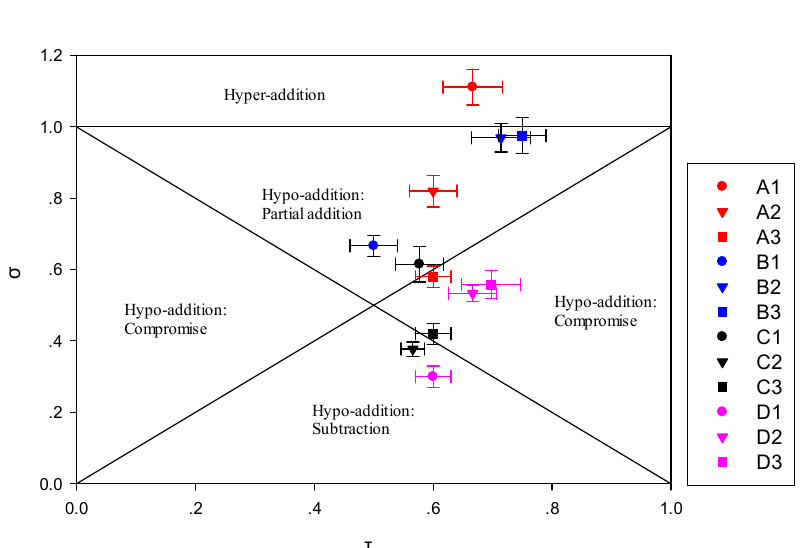
Figure 6. Individual impact of alcohols on sensory attributes of Terpenes Recombination. 1–3, at high, medium, and low level respectively. A, isoborneol; B, D -fenchyl alcohol; C, mixture of borneol and eudesmol; D, mixture of borneol and linalool; E, mixture of eudesmol and linalool; and F, mixture of borneol, eudesmol and linalool.